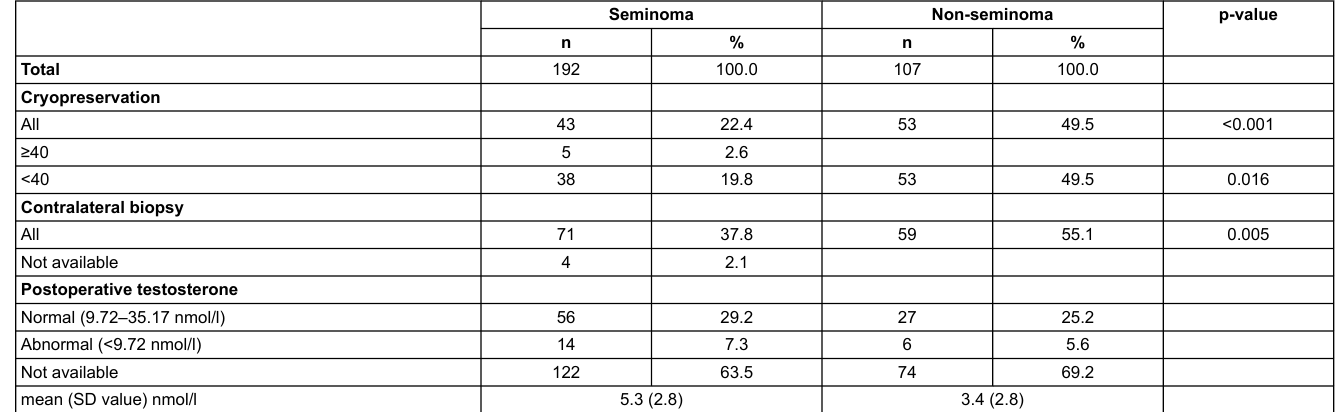
Table 3: Patient characteristics of the SAG TCCS cohort